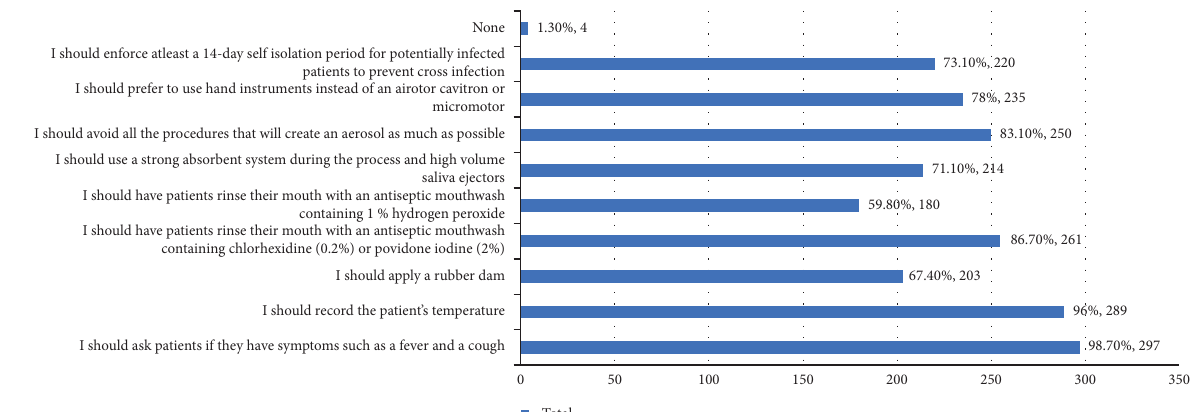
Figure 3: Precautions that you should be taking for the patients regarding COVID-19 while performing dental procedures. (select all that apply) 301